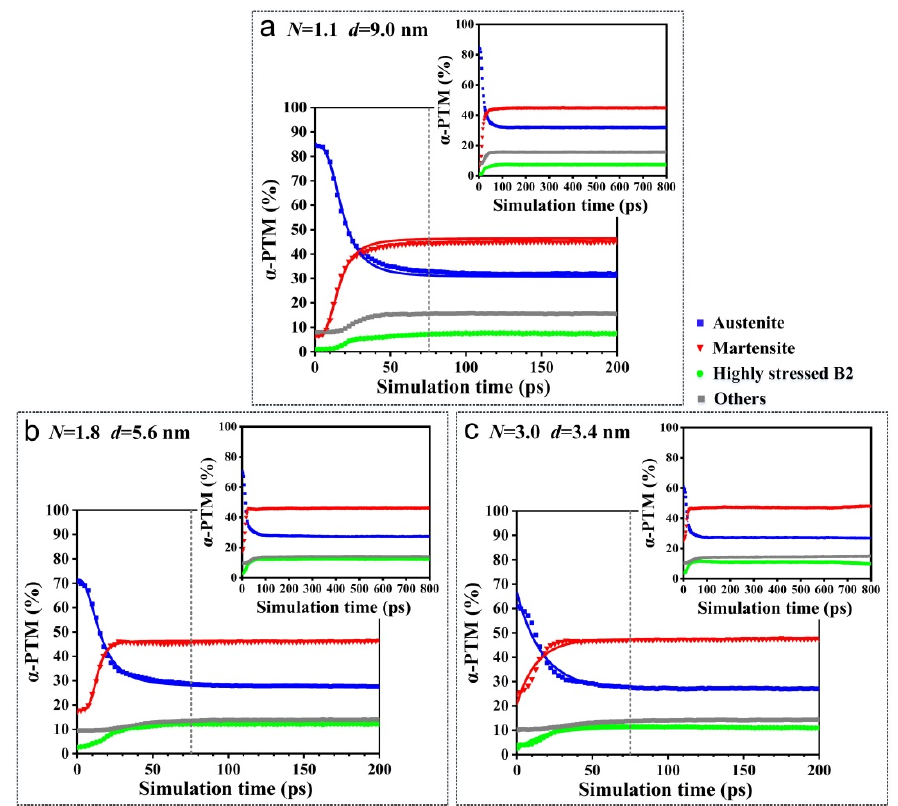
Figure 4. The relationship between the phase content and simulation time in different models with various grain sizes during torsion deformation. ( a ) Single crystal model with an average grain size of 9.0 nm; ( b ) Polycrystalline model with an average grain size of 5.6 nm; ( c ) Polycrystalline model with an average grain size of 3.4 nm.